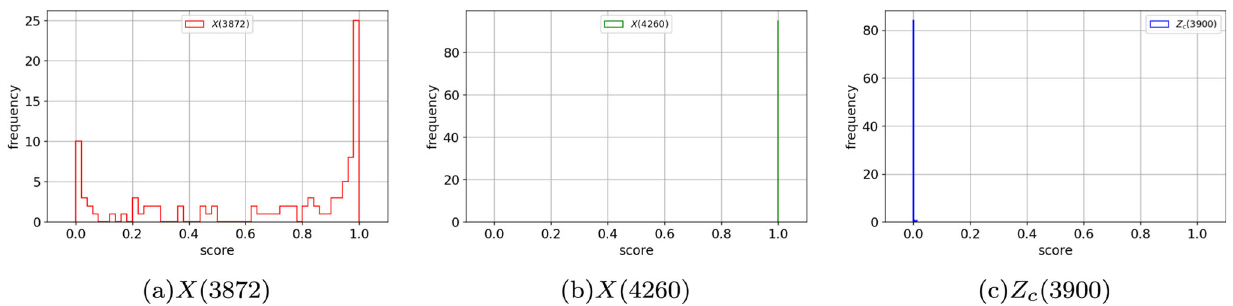
by the big error bars of the experimental data (see Fig.7a). When generating samples by Gaussian sampling, their line- shapes can change a lot within error bars which are used as standard deviations. So, one can reduce the standard devia- tions in Gaussian sampling to avoid misleading. As shown in Fig. 7b, with smaller standard deviations, the outputs are converged to a molecular state, i.e., scores of the most sam- ples are < 0.5. That means, neural network can also identify hadronic molecules using only one invariant mass spectrum if the experimental error bars are small